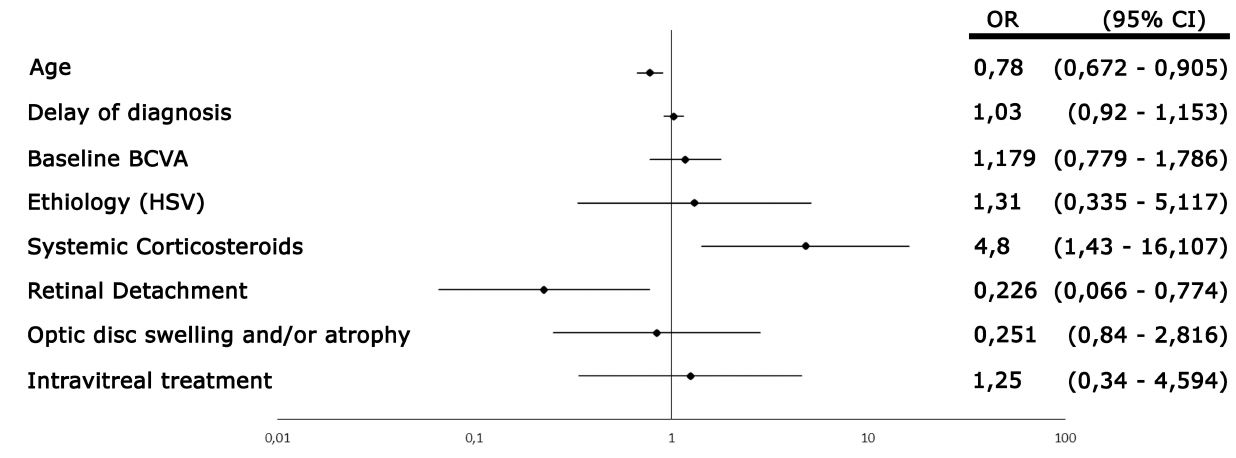
FIGURE 3 | Forest plot showing the result of the regression analysis performed on the published data. Age, retinal detachment, and use of corticosteroids were the only parameters associated to best-corrected visual acuity (BCVA) improvement. HSV: herpes simplex virus, OR: odds ratio; CI: confidence